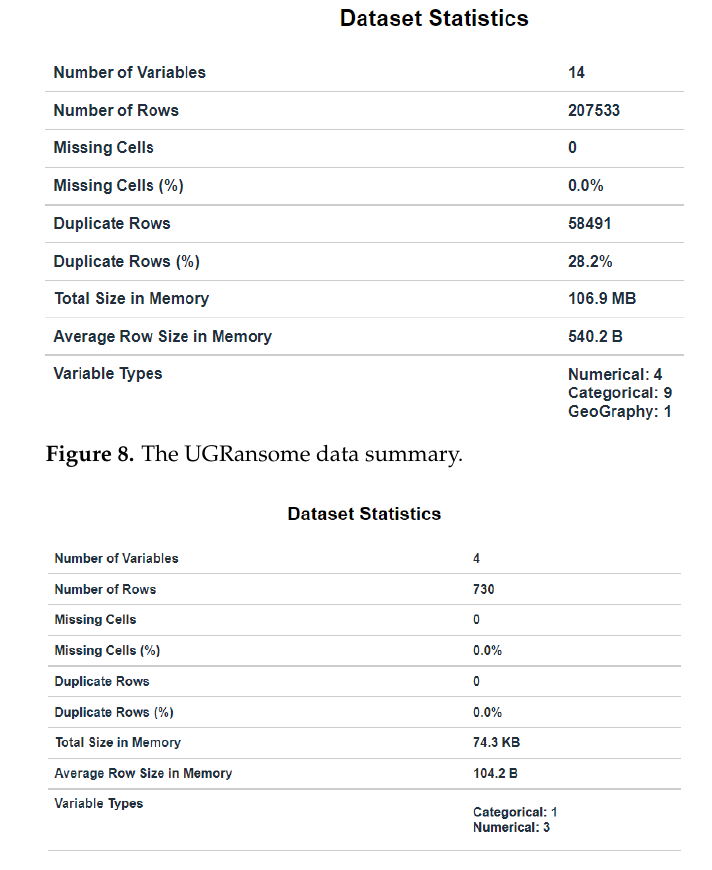
Figure 9. The subscriber data